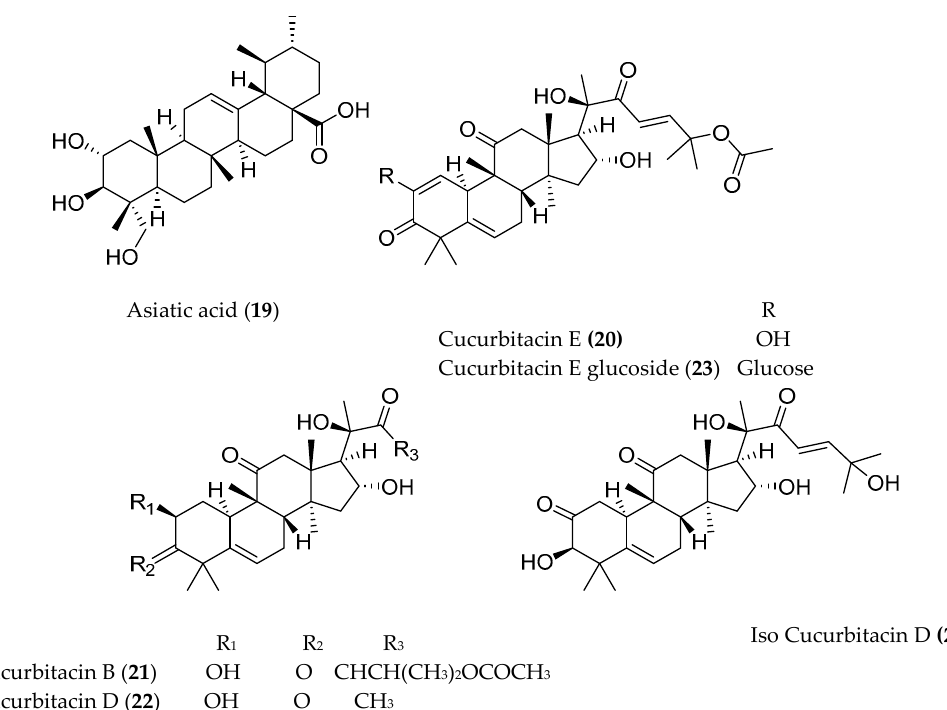
Figure 2. Structures of anticancer terpenoids reported from plants available in Ethiopia.